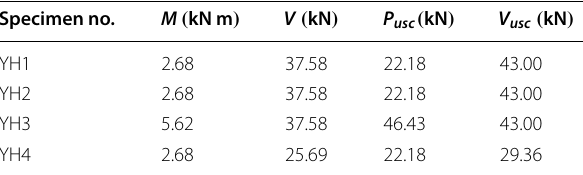
Table 6 Static bearing capacity of specimens. Specimen